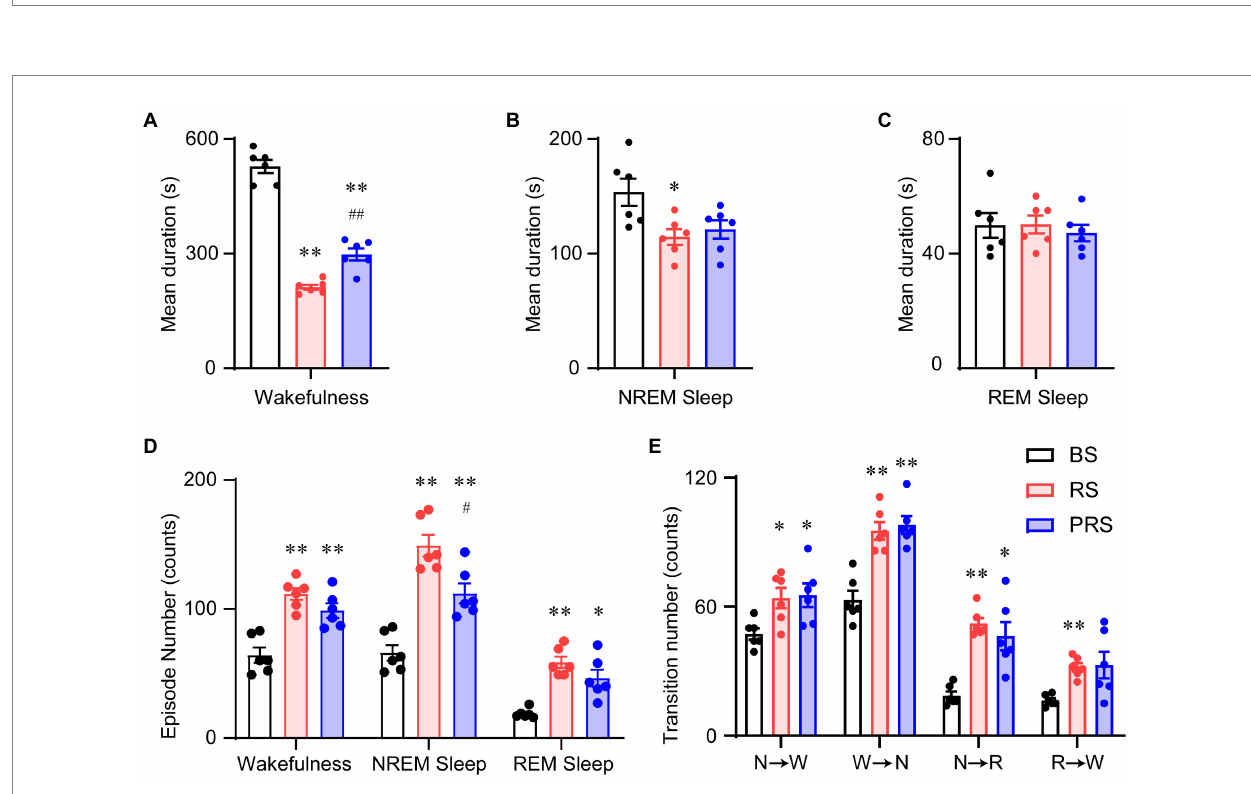
FIGURE 6 Sleep–wake architectures in the baseline, RS, and PRS groups during ZT 12–24. Mean durations of wakefulness (A) , NREM sleep (B) , REM sleep (C) . Episode numbers of each stage (D) during ZT 12–24. (E) Stage transitions between stages during 12 h at ZT12–24. * p < 0.05, ** p < 0.01 versus baseline, # p < 0.05, ## p < 0.01 versus RS, n = 6. BS, baseline; RS, restraint stress; PRS, post-restraint stress; R, REM sleep; S, NREM sleep; W, wakefulness.